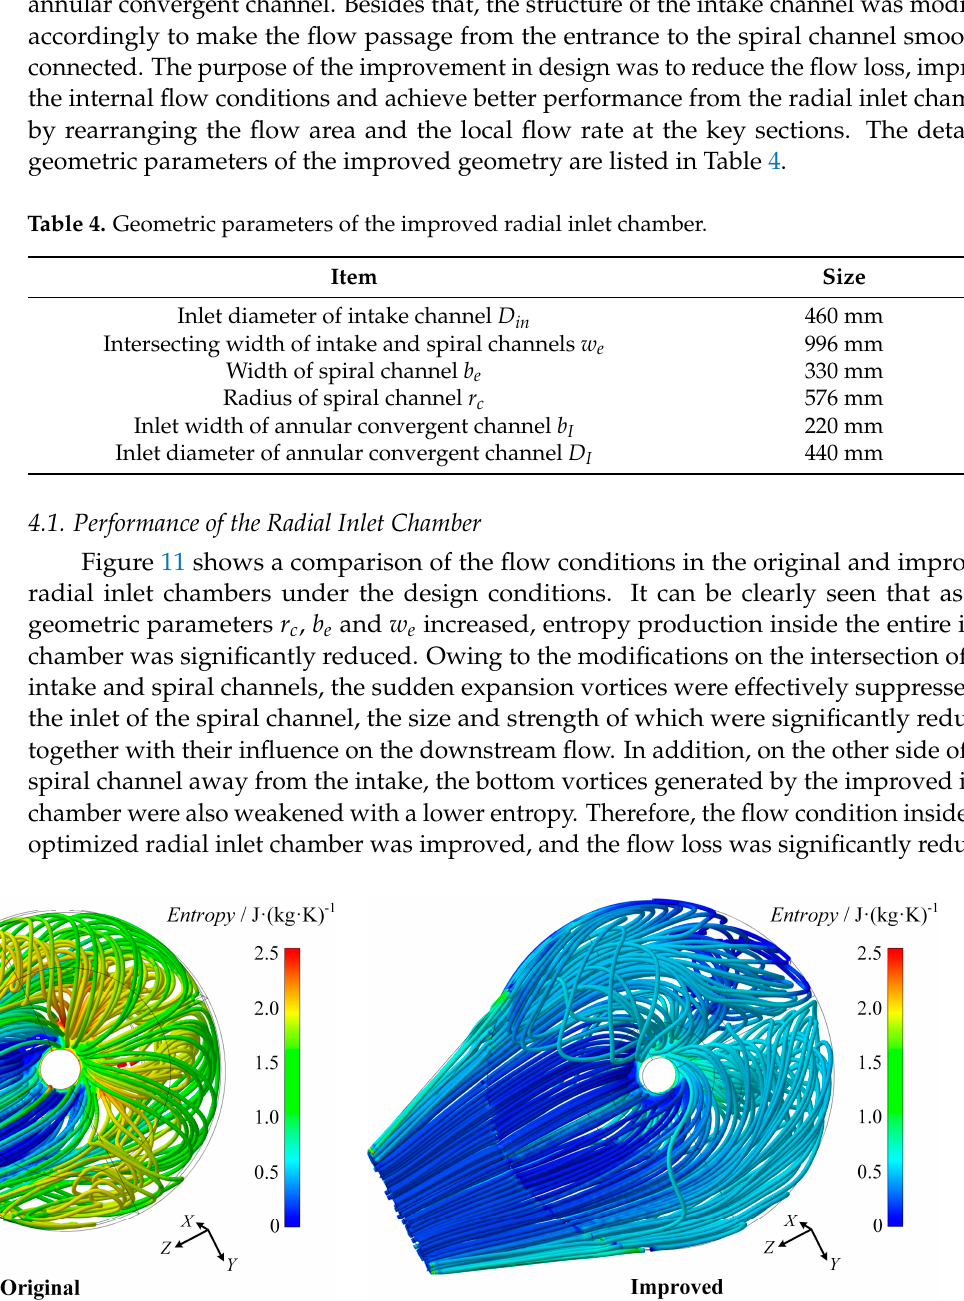
Figure 11. 3D flow conditions in the original and improved radial inlet chambers.